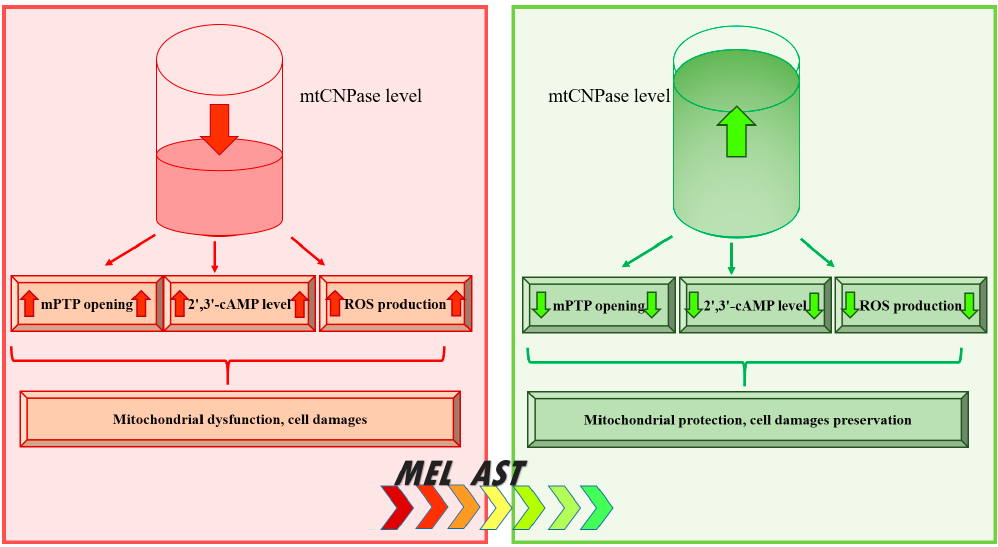
Figure 5. Schematic representation of the role of CNPase in pathologies.